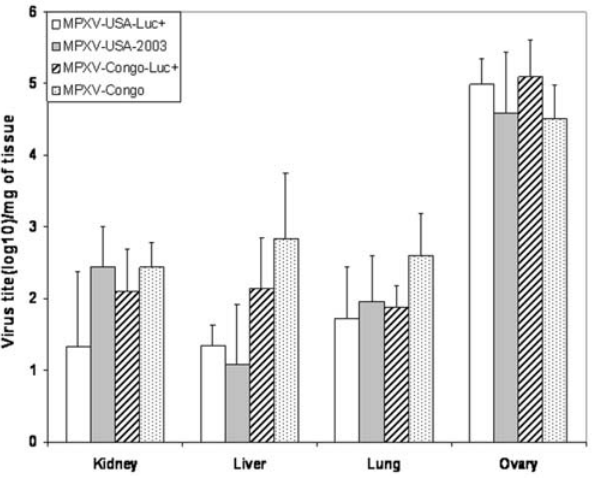
Figure 4. Virus titers from selected tissues and correlation with luminescence. Tissues samples from kidney, liver, lung and ovaries were aseptically harvested to compare viral titers between the parental MPXV-USA-2003 and recombinant progeny MPXV-USA-Luc + strains. Tissue homogenates were centrifuged as described in materials and methods section. Viral titers were calculated per gram of tissue.